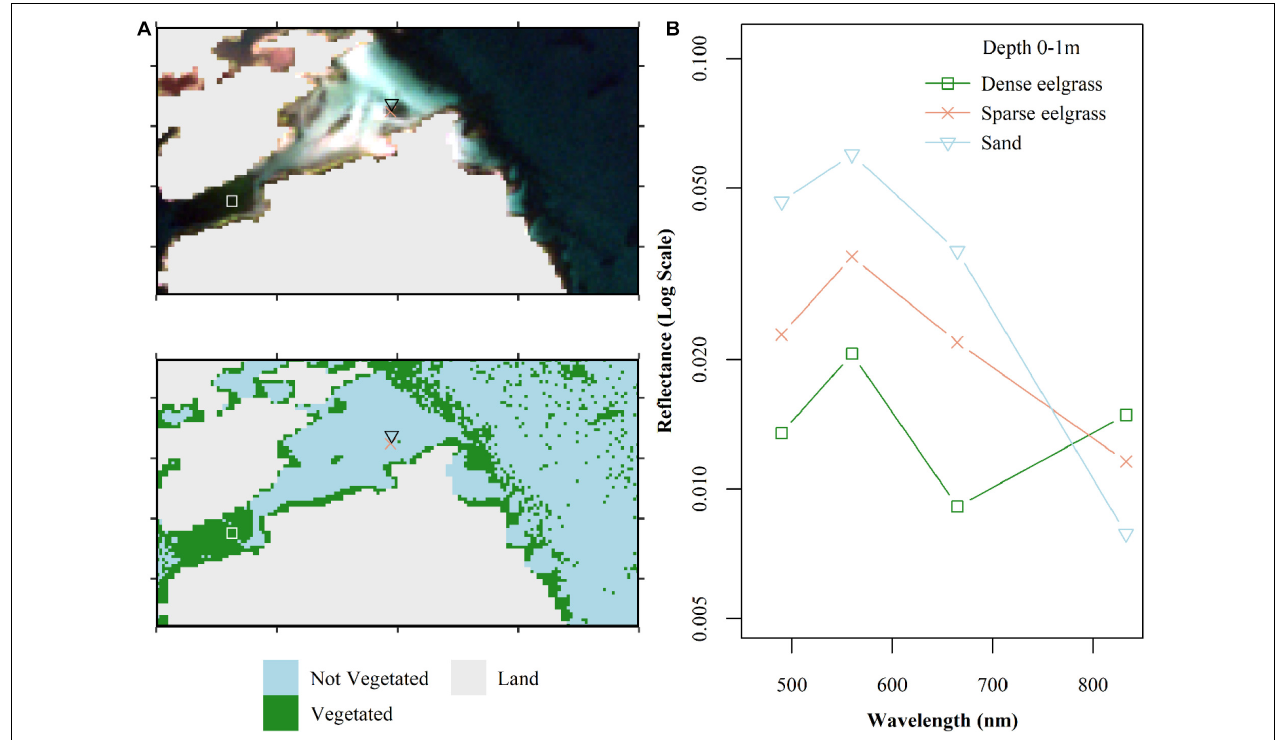
FIGURE 8 | Finalized classification of the Sentinel-2 image from September 13, 2016 highlighting how low-density vegetation is misclassified. (A) True color composite and resulting map classification (thresholded at ≥ 80% probability of being vegetated) indicating location of field survey points of a sandy habitat (black triangle), low density eelgrass (red x), and a large, dense eelgrass bed (white square). (B) Spectra for the same three survey points which all are between 0 and 1 m of water depth. Note the low-density eelgrass training point would not have been included in model training (see section “Field